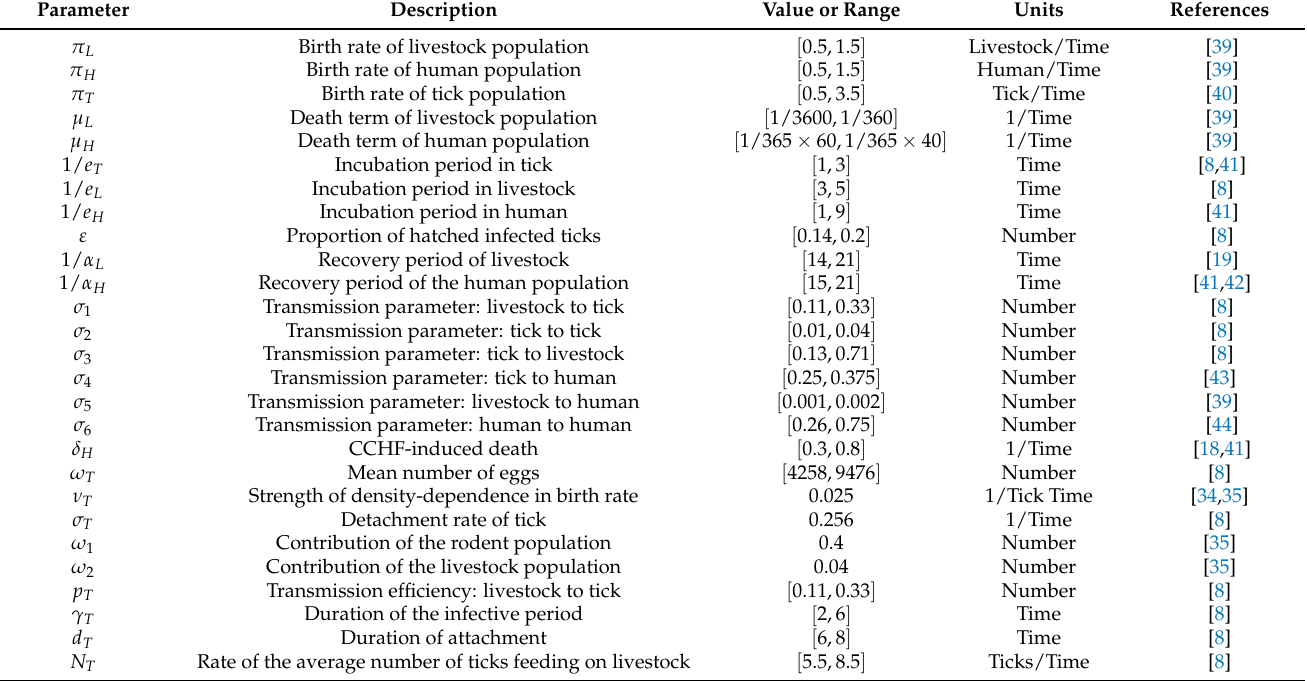
Table 1. Parameters used in the model (1)–(4),